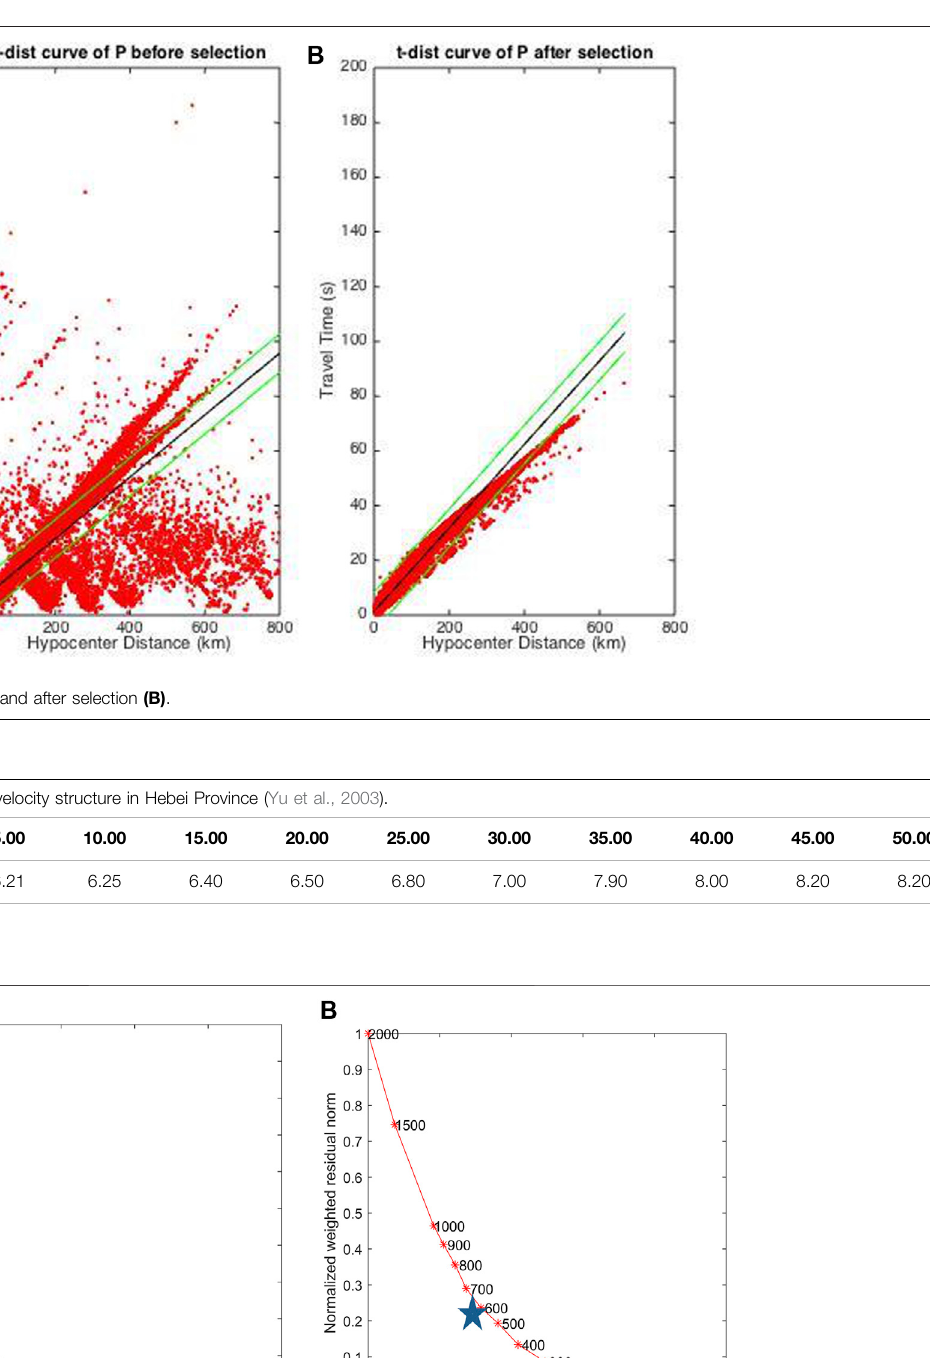
FIGURE 4 | Trade-off curves for determining the best values of smoothing (A) and damping (B) parameters.